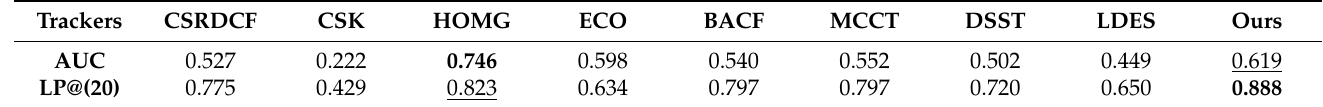
Table 3. Comparison with the state-of-the-art correlation filters trackers on